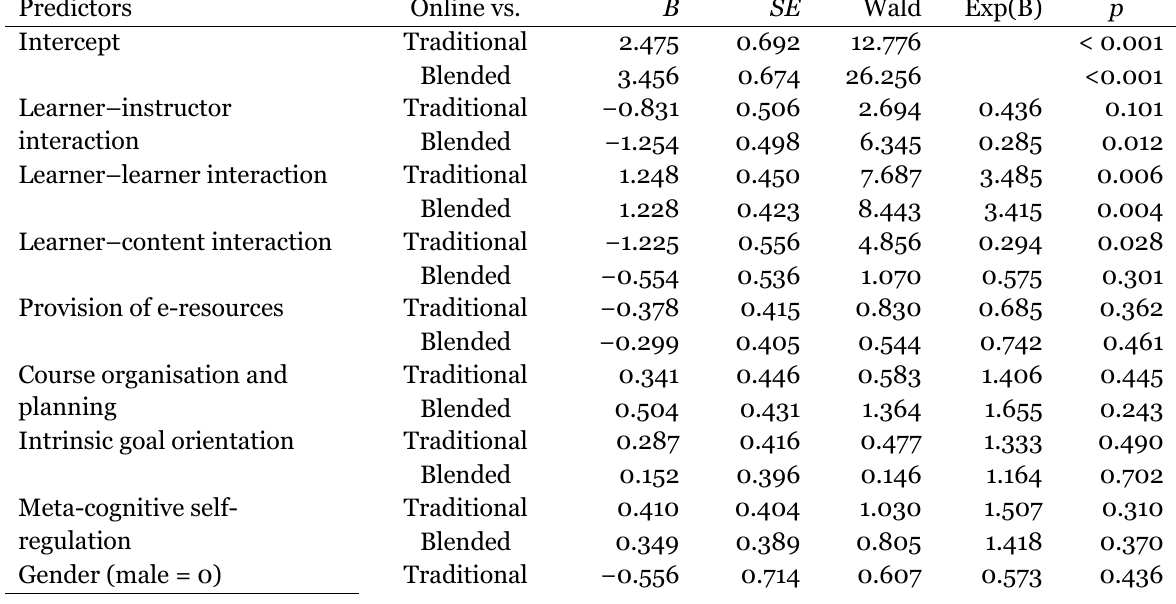
Multinominal Logistic Regression on Intention to Continue Online Learning